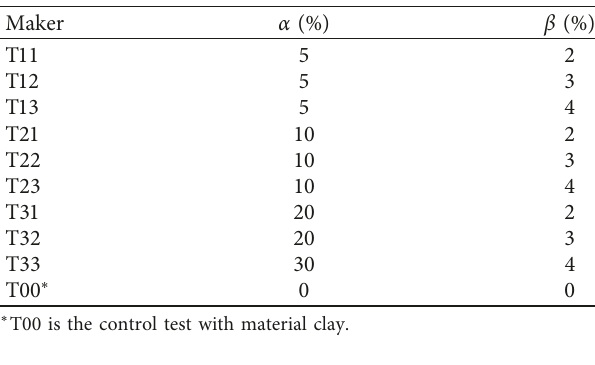
Table 2: Proportions of cement and EPS.